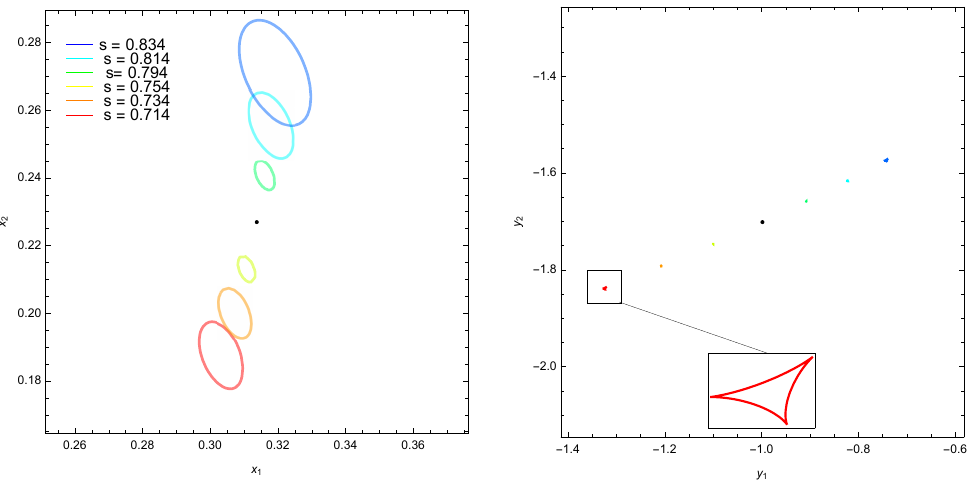
Figure 6. The elliptic umbilic catastrophe for n = 2, m = 0.25 and 0.714 ≤ s ≤ 0.834 in steps of 0.02, one color for each s from red to blue. The separation at which the catastrophe occurs is s euc = 0.774. Critical curves on the left side panel, caustics on the right side